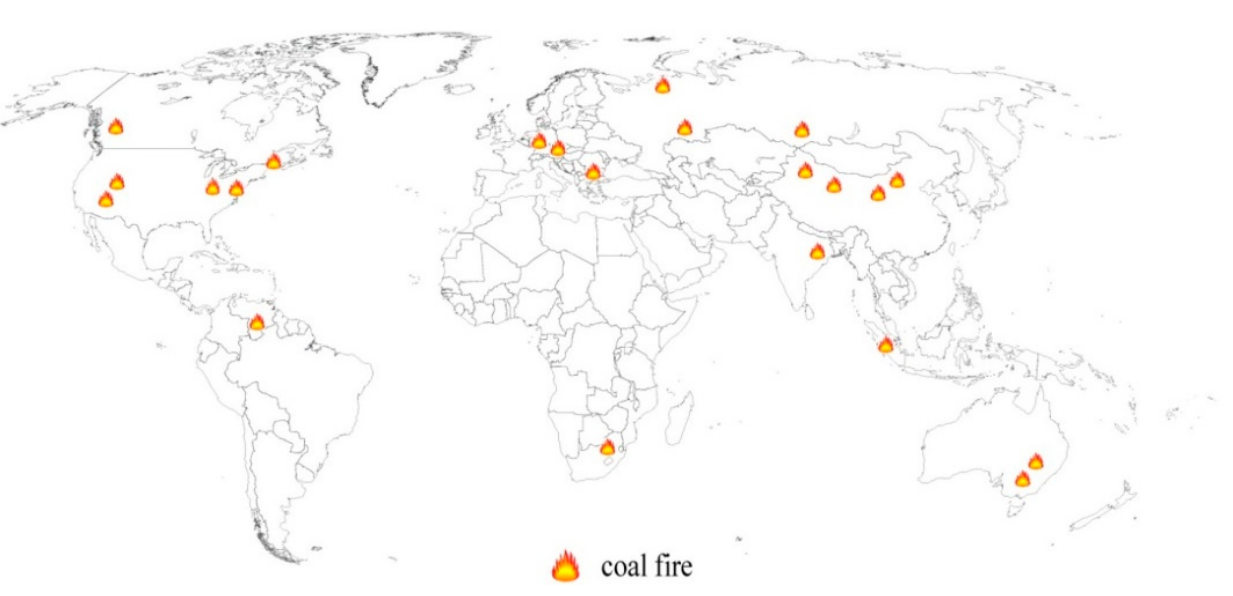
Figure 1. Global distribution of coal